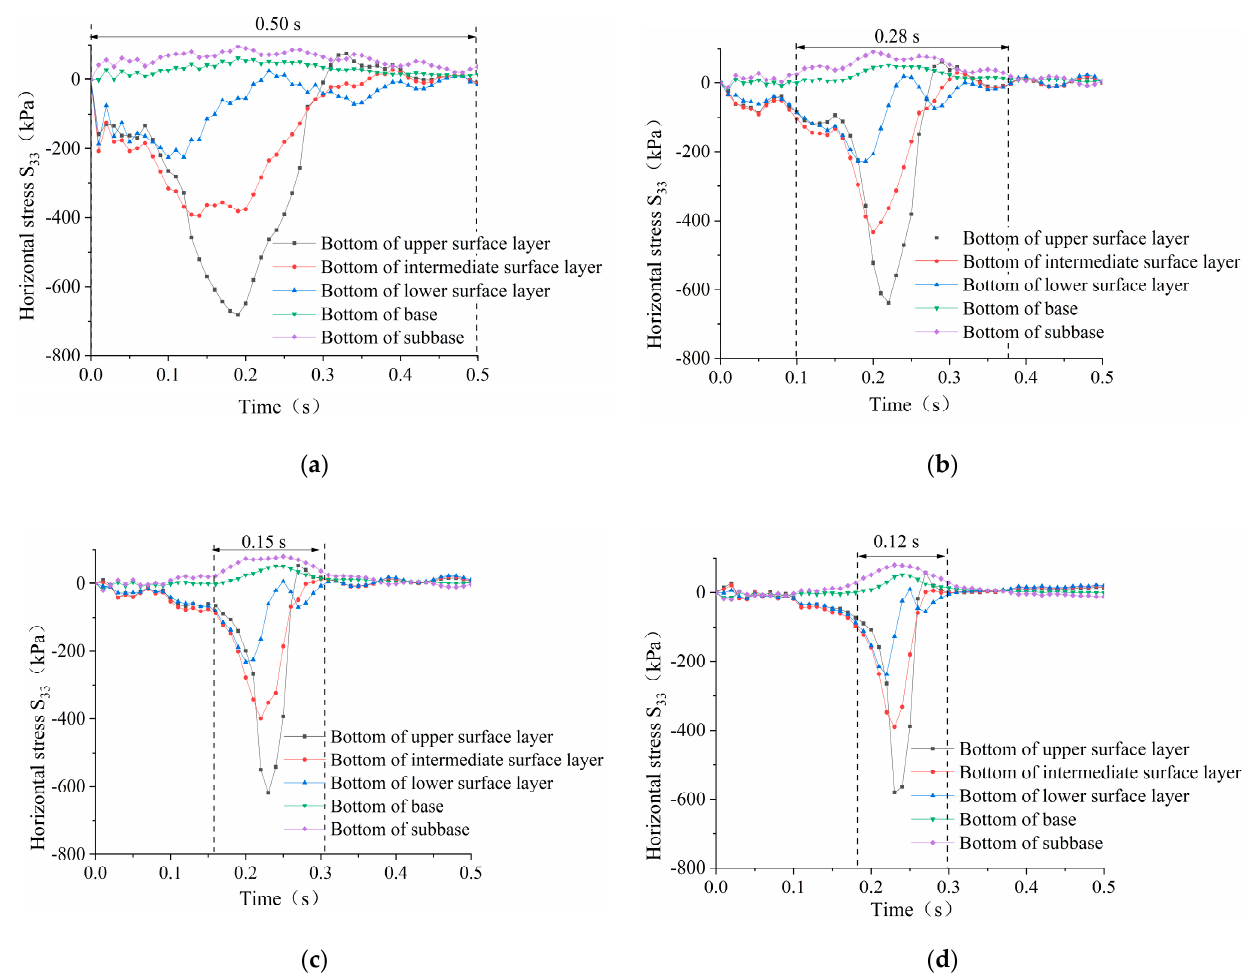
Figure 10. Variation in horizontal stress over time at initial speeds of ( a ) 10 km/h, ( b ) 20 km/h, ( c ) 30 km/h, and ( d ) 40 km/h.